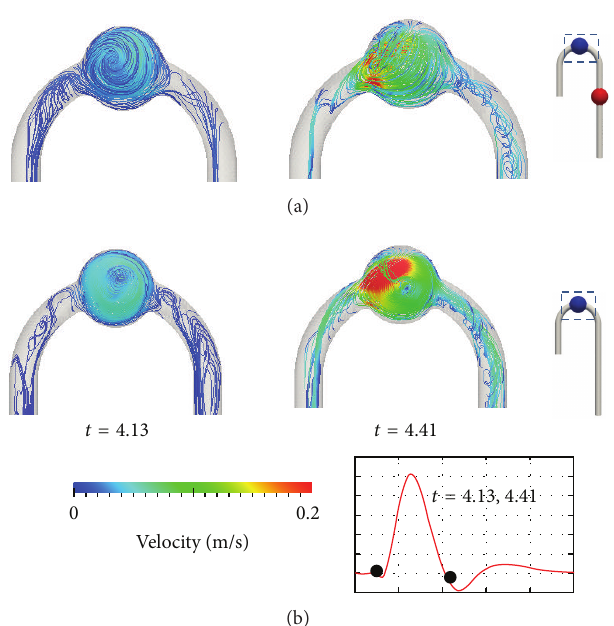
Figure 7: Helical flow at ascending and descending aorta 𝑡 = 4.13 and 𝑡 = 4.41 second: (a) DAA, (b) TAA cured